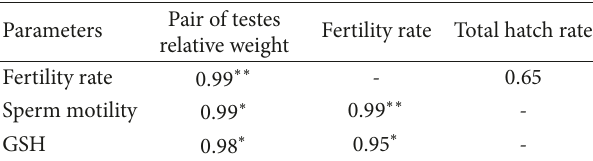
Table 5: Correlations between testes weight, GSH, sperm motility, total hatch, and fertility